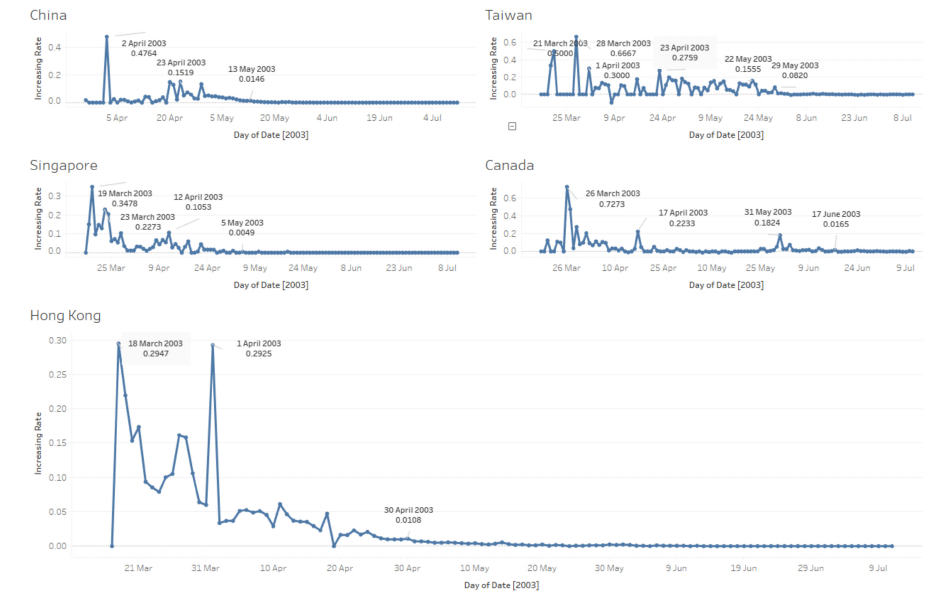
Figure 4. Daily changing rate of infected case numbers of five countries and regions. (18 March–11